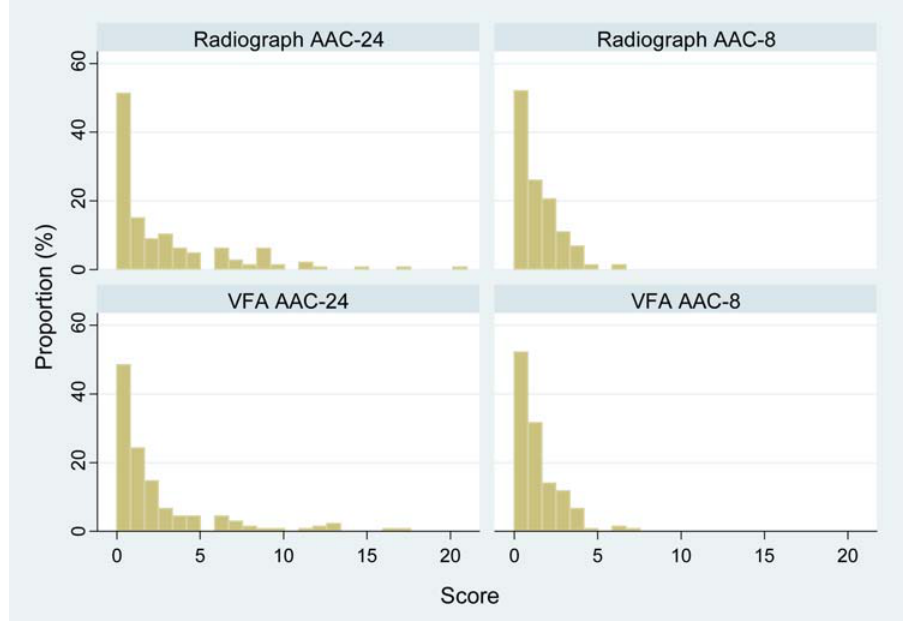
Figure 2. Frequency Distributions of 24-Point and AAC-8 Scores on Radiographs and VFA Images. doi:10.1371/journal.pone.0000715.g002 PLoS ONE |